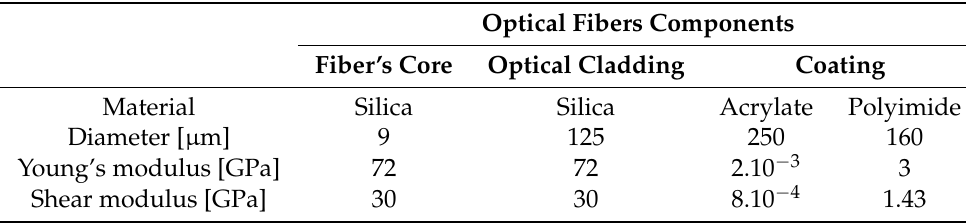
Table 1. Mechanical properties and dimensions of the optical fiber components